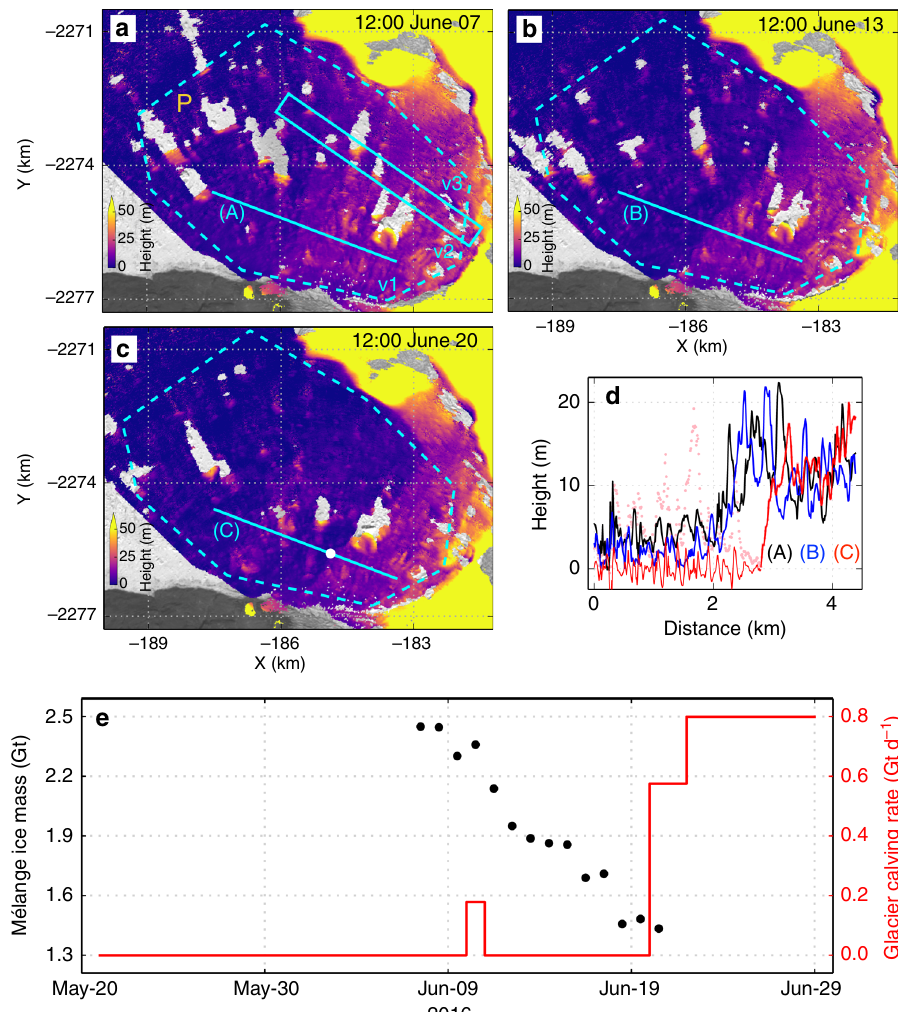
Fig. 7 Mélange ice loss and glacier calving rate. a – c Surface elevation maps at selected times. Dashed polygon P outlines a test area used to calculate ice loss, moving with the three vertices v1 – v3 adjacent to the glacier (marked in ( a )). Cyan rectangle in ( a ) marks an area whose elevations are shown in Fig. 10a. d Elevations of an Eulerian pro fi le marked by cyan lines in ( a – c ), large icebergs downstream from the white dot of ( c ) (shown with pink dots) were fi ltered for clarity. e Black dots show inferred ice mass within the test area; red line shows calving rate in daily